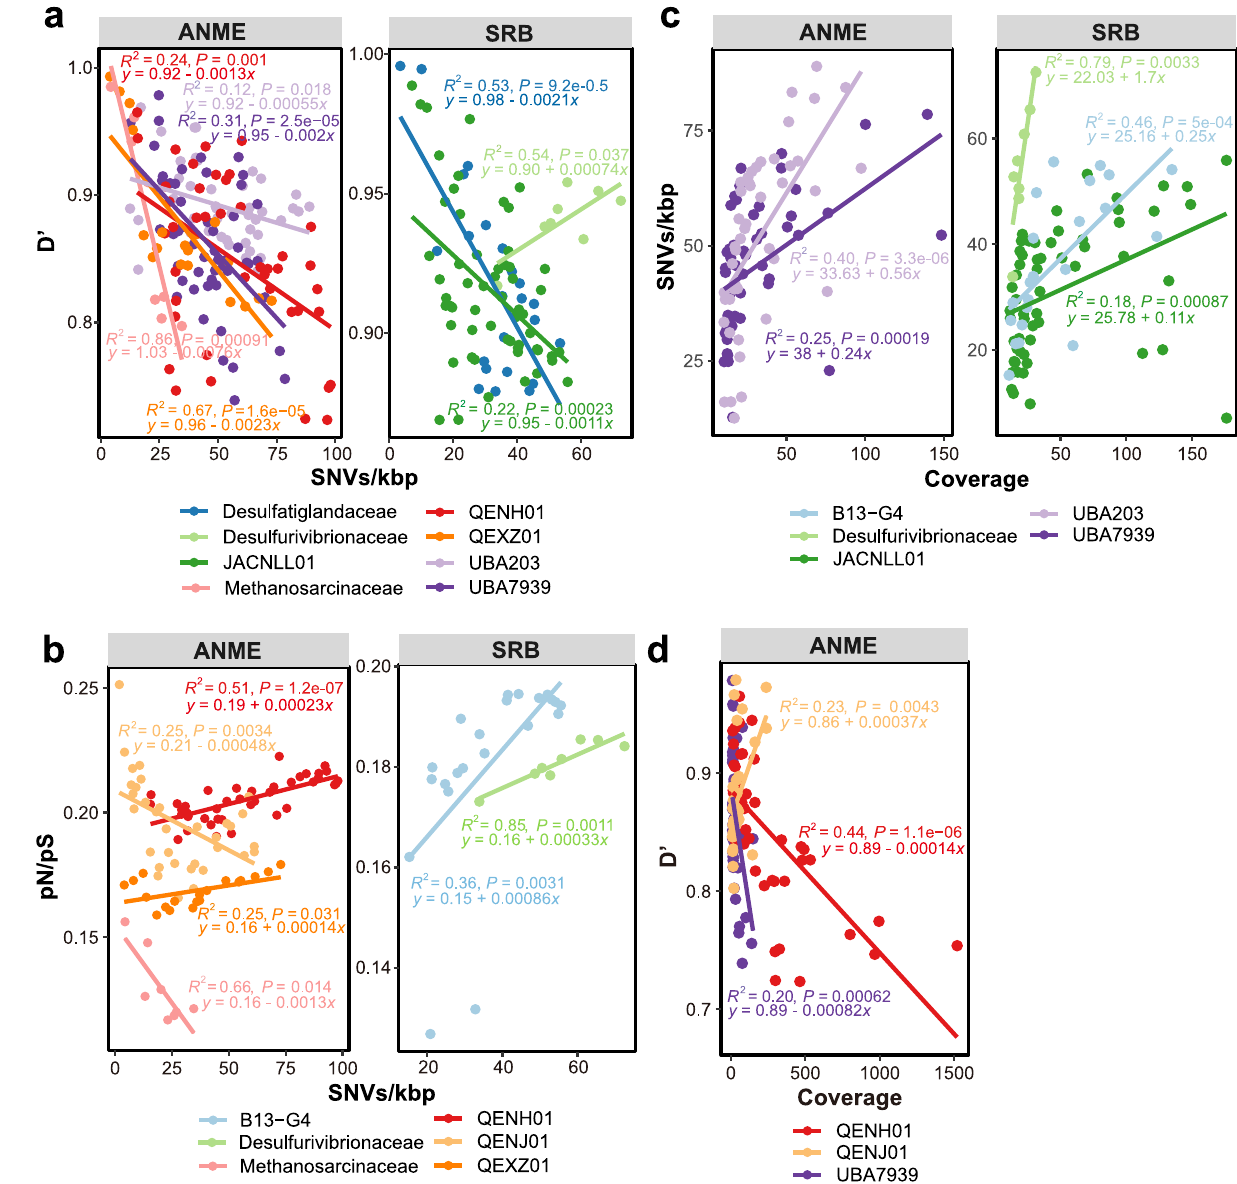
Fig. 4 | Genome-wide comparison of evolutionary metrics for microbial populations in cold seep sediments. a , b D ’ and pN/pS ratio in relation to SNV density. c , d SNV density and D ’ in relation to genome coverage. Each dot repre- sents one species-level microbial population. Linear regressions and R 2 values are